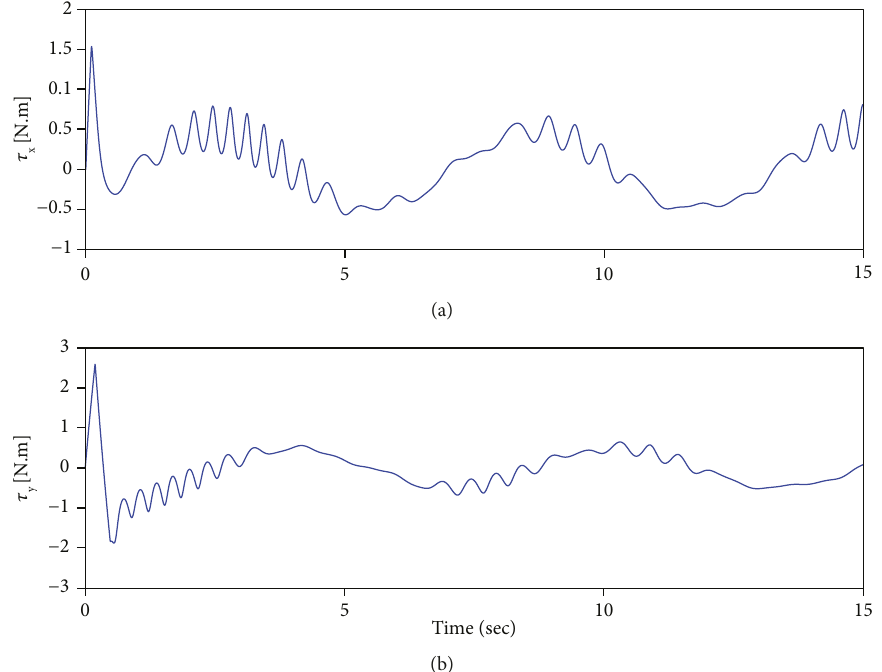
Figure 7: The input torques applied to the